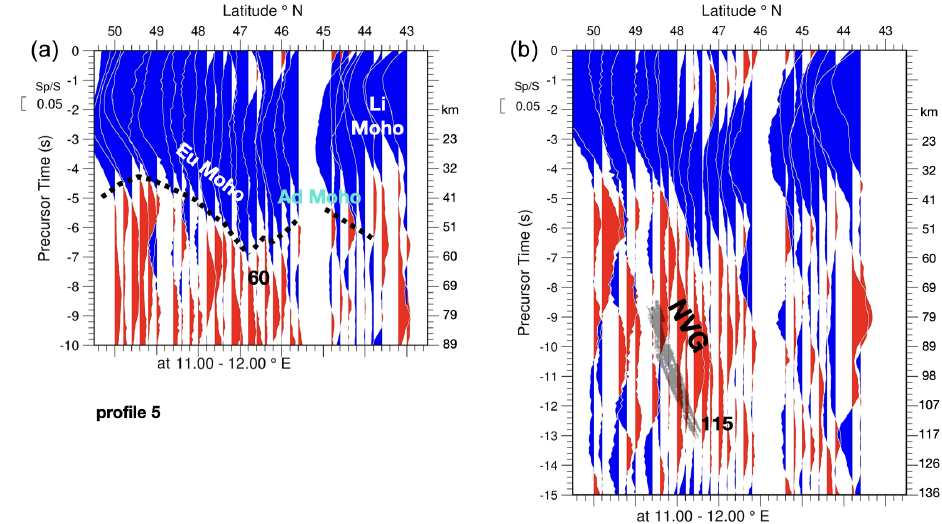
Figure 7. Profile 5. North–south profiles at 11–12 ◦ E, i.e. near the western margin of the Tauern Window. Note that the deepest point of the Moho at 46.5 ◦ latitude closely coincides with the Europe–Adria boundary according to Spada et al. (2013) (see Fig. 2). The base of the much shallower Ligurian Moho depicted in Fig. 2 marked “Li Moho” is visible at around 43.5 ◦ latitude.